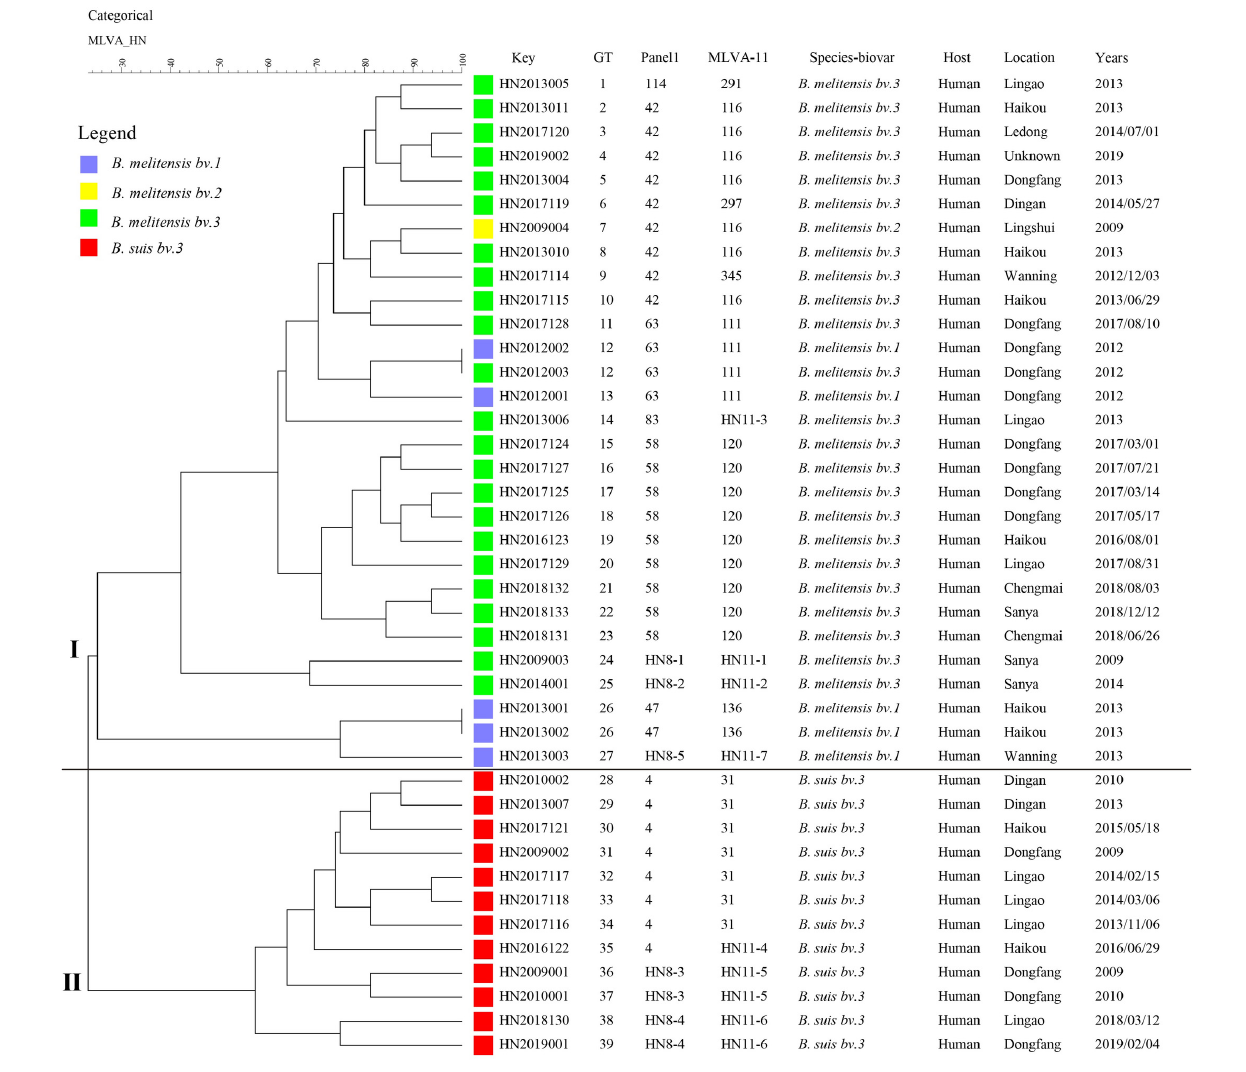
FIGURE 2 | A dendrogram based on the MLVA-16 genotyping assay (UPGMA method) showing the relationships between the 41 Brucella isolates. The columns show the identification numbers (Key), MLVA-16 genotypes (GT), panel 1 genotypes and MLVA-11 (panels 1 and 2A) genotypes, species biovar, host, location, and the year the strains were